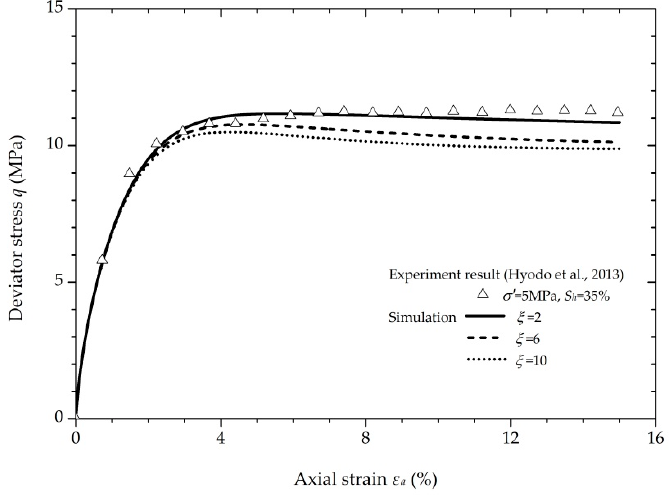
Figure 4. Calibration of the damage parameters.